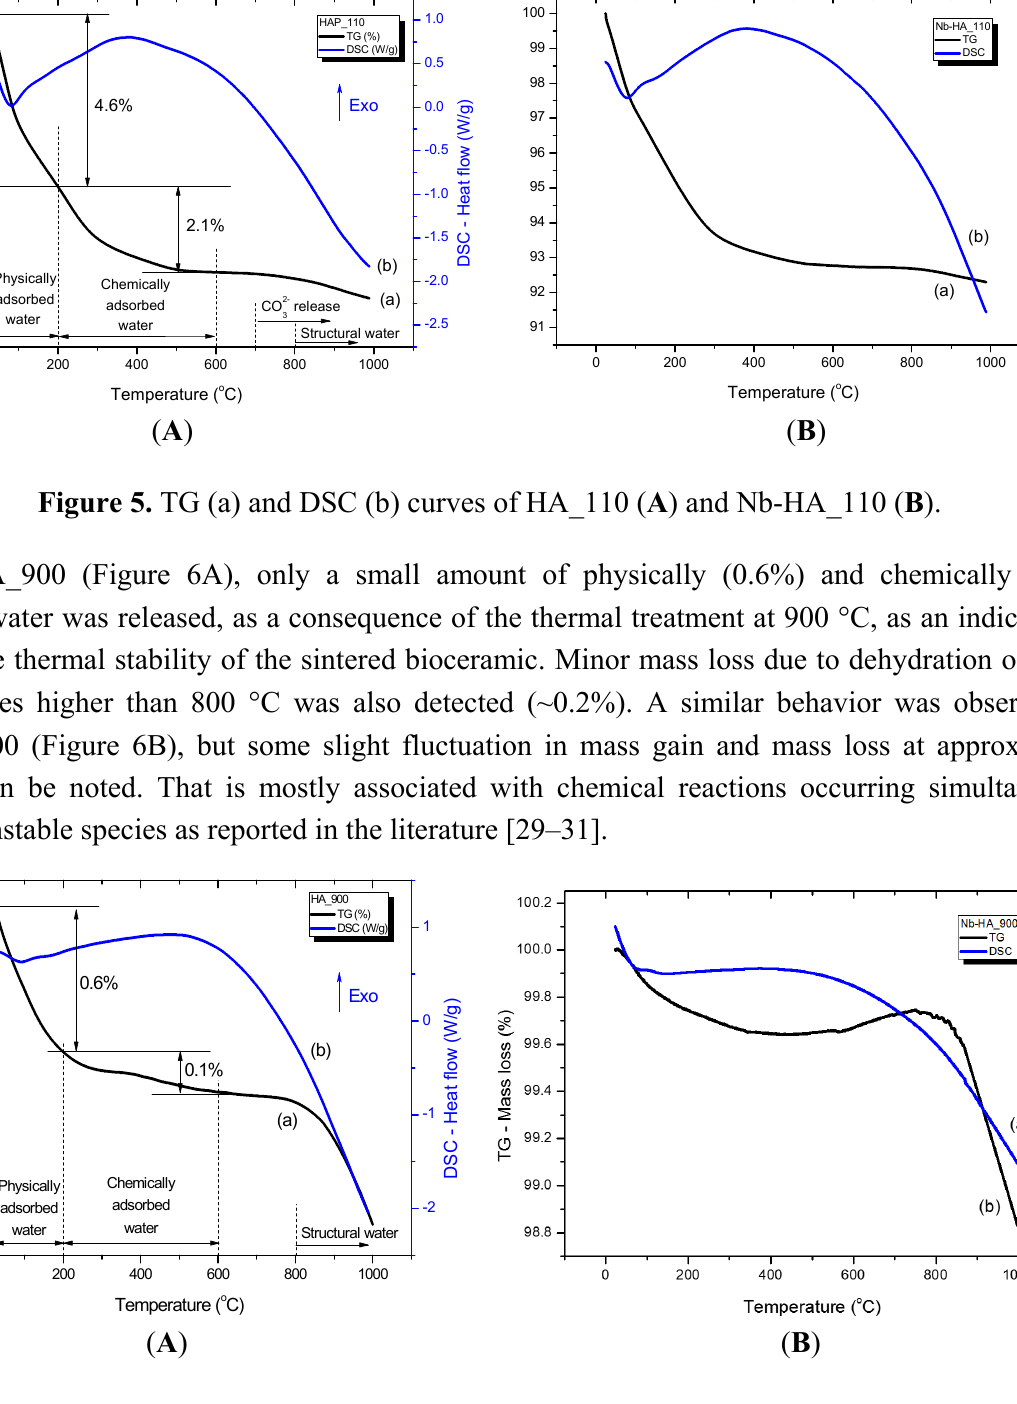
Figure 6. TG (a) and DSC (b) curves of HA_900 ( A ) and Nb-HA_900 ( B